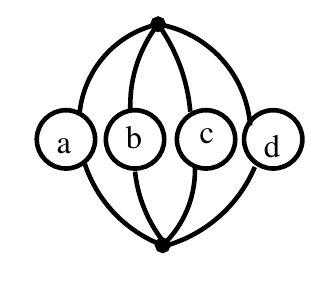
Figure 2 . The modular graph C a;b;c;d